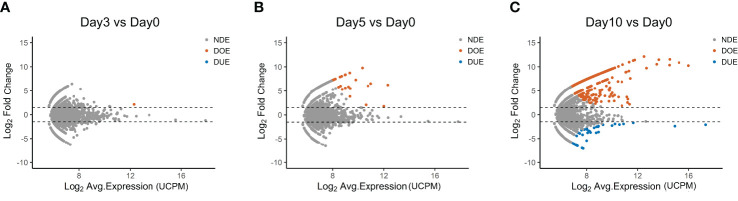
Selection of Differentially Expanding TCR clones using edgeR. (A–C) MA plots showing the differential expansion of individual TCR clones calculated with edgeR between the day 0 and (A) day 3, (B) day 5, or (C) day 10 repertoire. Each dot represents an individual TCR clone where the x- and y-axes depict the average log2 clonal frequency (calculated from UMI counts per million; UCPM) and log2 fold change compared to day 0 respectively. Differentially (Benjamin–Hochberg corrected p-value <0.05) Over-Expanded clones (DOE; fold changes >1.5) are colored in orange, Differentially Under-Expanded clones (DUE; fold changes < −1.5) are colored in blue, while Not Differentially Expanded clones (NDE, −1.5 < fold changes < 1.5) are colored in gray.